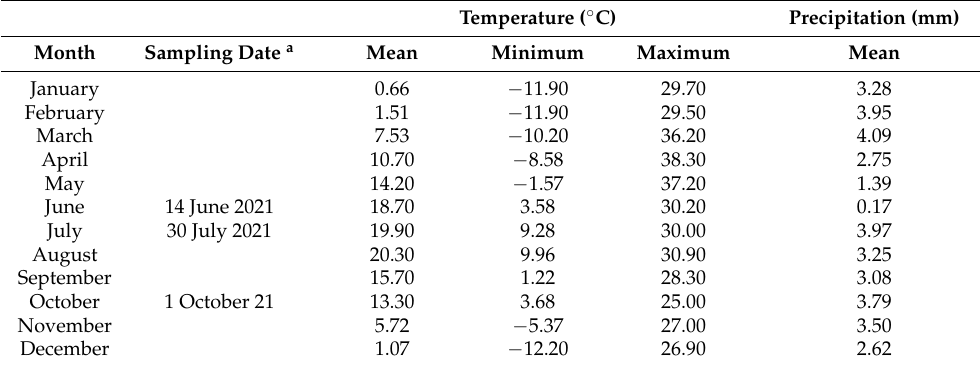
Table 2. Mean monthly temperatures recorded outside of the mesh cages at Gullion Fork near Wytheville, VA. Temperatures were recorded every 60 min using dataloggers on site. Precipitation data were obtained from the NOAA database.